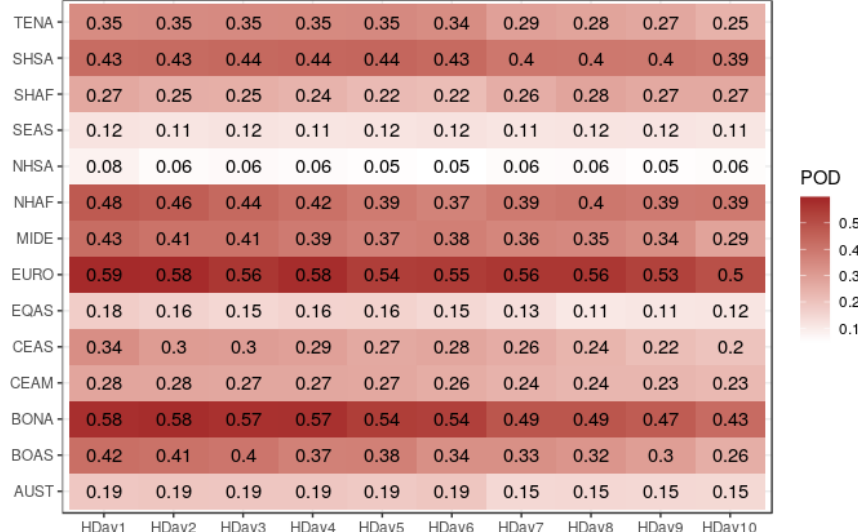
Figure 7. Regional probability of detection (POD) for the high-resolution forecasts from day 1 to 10 (HDAY1/10). Events where FRP ≥ 0.5Wm − 2 are categorized as “hits” and compared to the FWI prediction above the high warning level (90th percentile of clima- tology). The statistics are constructed using FRP observations detected in